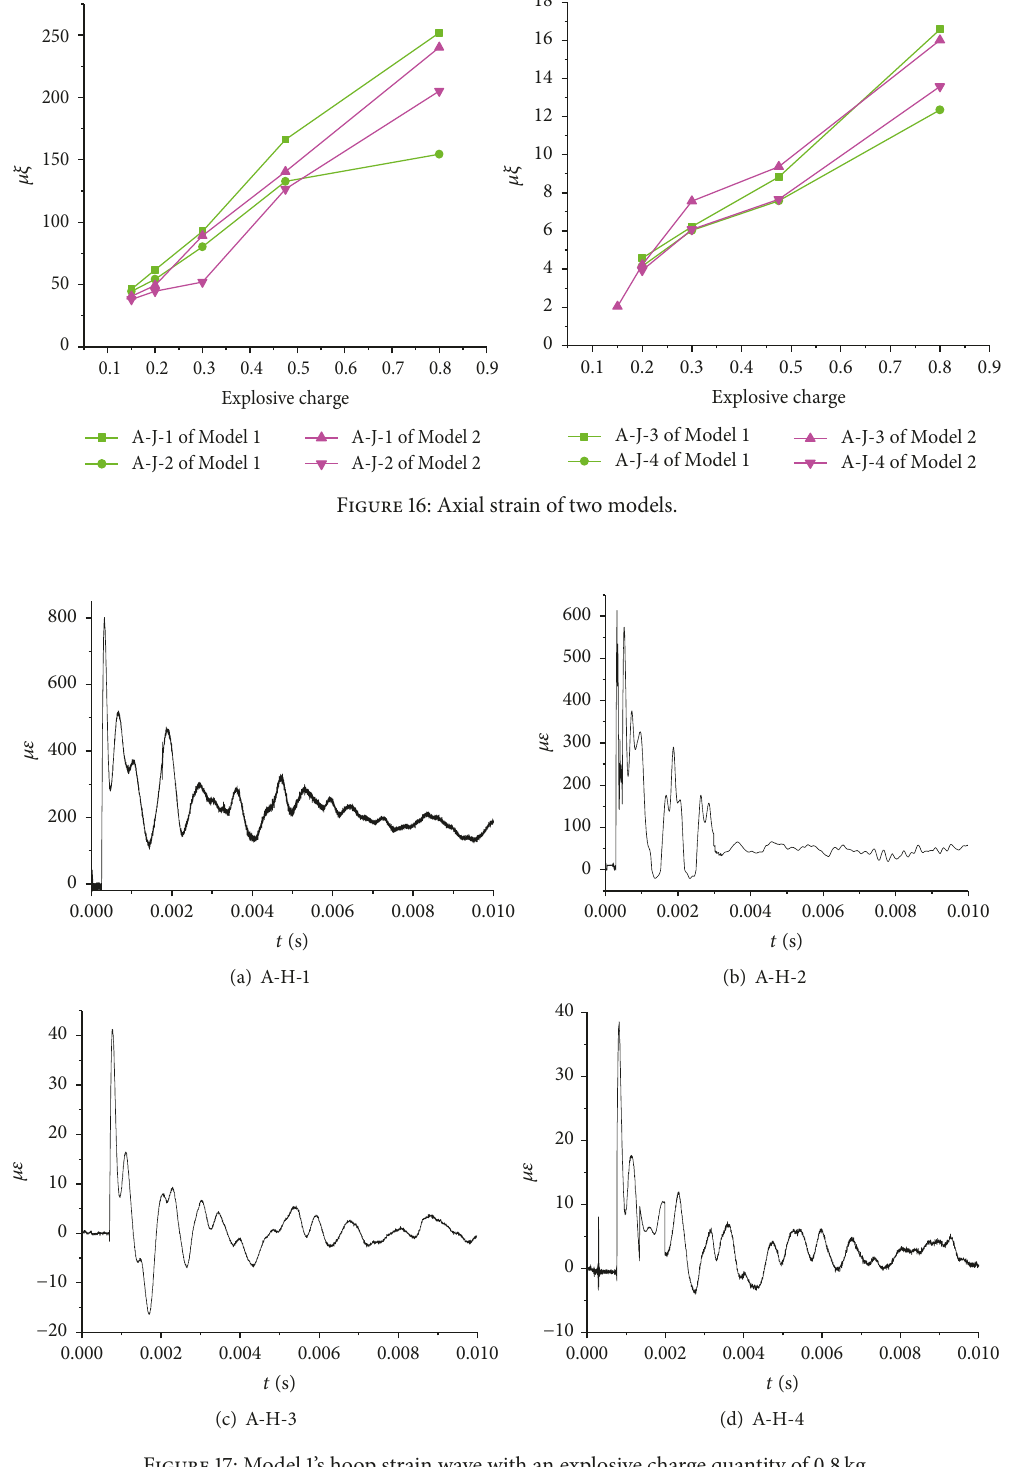
Figure 17: Model 1’s hoop strain wave with an explosive charge quantity of 0.8 kg.